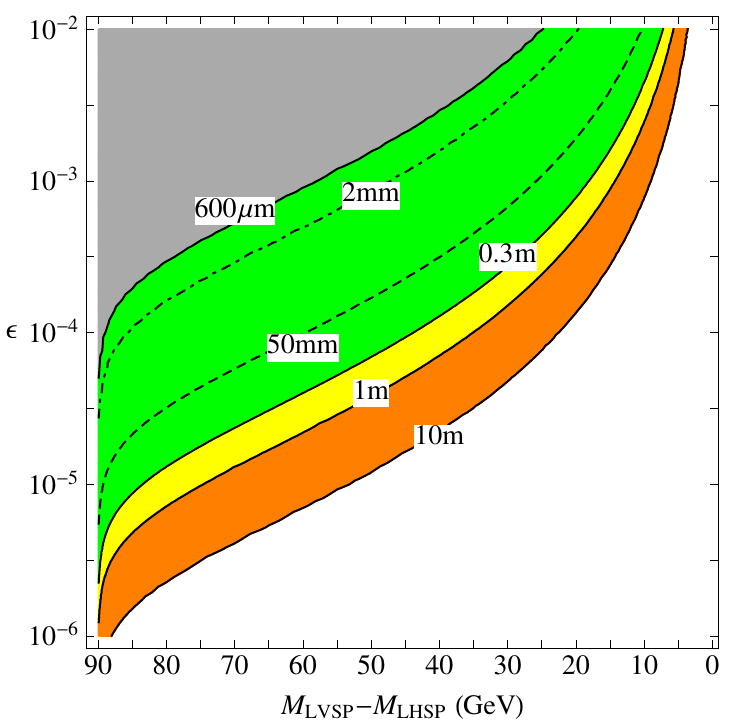
Figure 6. Proper decay lengths of the LVSP into an o(cid:11)-shell Z -boson and the LHSP for M LVSP M LHSP < m Z , such that there can be displaced decays. We have chosen as a reference